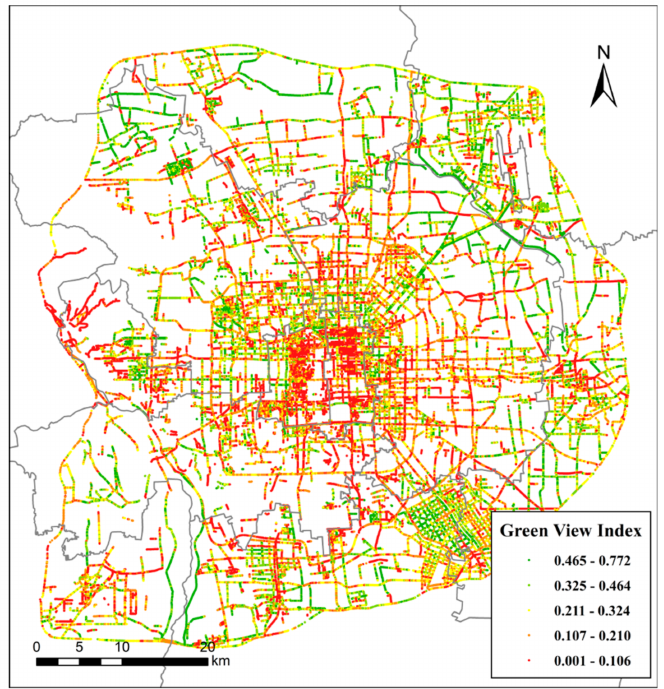
Figure 7. The green view index (GVI) values at sampling sites in the study